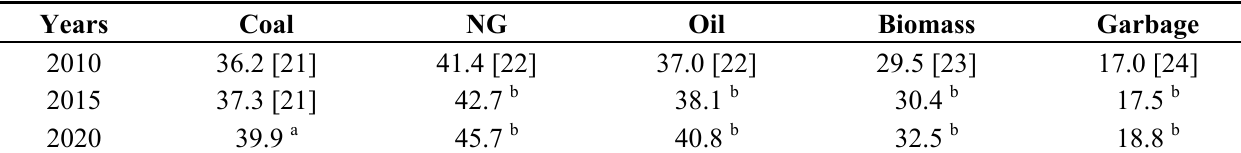
Table 1. Energy conversion efficiencies (ECEs) of different fuels during the electricity generation processes (%).